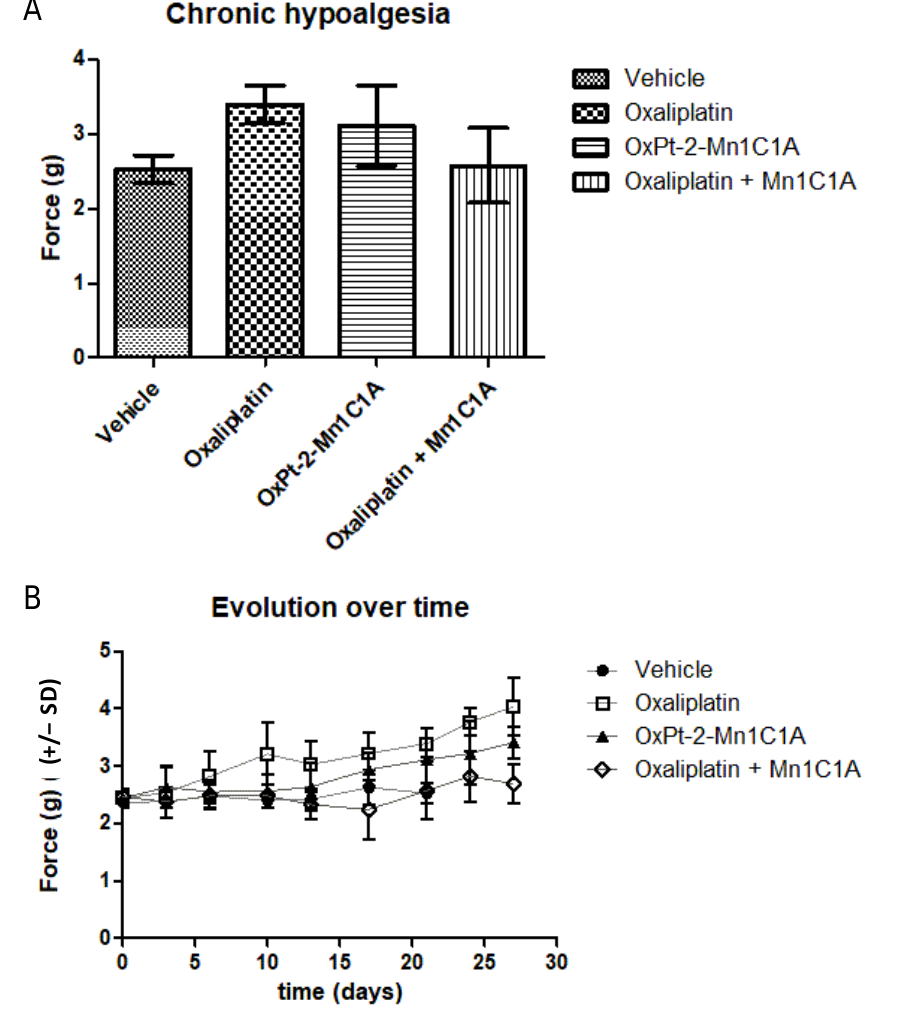
Figure 7. Von Frey test evaluating chronic hypoalgesia reflecting oxaliplatin-induced neuropathy. Balb/c mice inoculated with CT26 cells treated by weekly intraperitoneal injection with vehicle (8 mice), oxaliplatin (8 mice, 10 mg/kg/week), OxPt-2-Mn1C1A (9 mice, 10 mg/kg/week), and Mn1C1A + oxaliplatin (9 mice, 10 mg/kg/week). ( A ) Mean Von Frey scores over the whole exper- iment, showing statistical significance between Mn1C1A + oxaliplatin with less hypoalgesia than oxaliplatin alone ( p < 0.05). ( B ) Von Frey score evolution over time (days) in the different groups. The Von Frey basal score was the same in each group. In the oxaliplatin group, hypoalgesia appeared after the first oxaliplatin injection and worsened over time. In the OxPt-2-Mn1C1A group, hypoalgesia appeared later and with lower intensity, but no statistical difference was observed compared to oxaliplatin. In the Mn1C1A + oxaliplatin group, no hypoesthesia appeared at the end of the experi- ment. The difference was statistically significant and showed neuroprotective activity of Mn1C1A associated with oxaliplatin compared to oxaliplatin